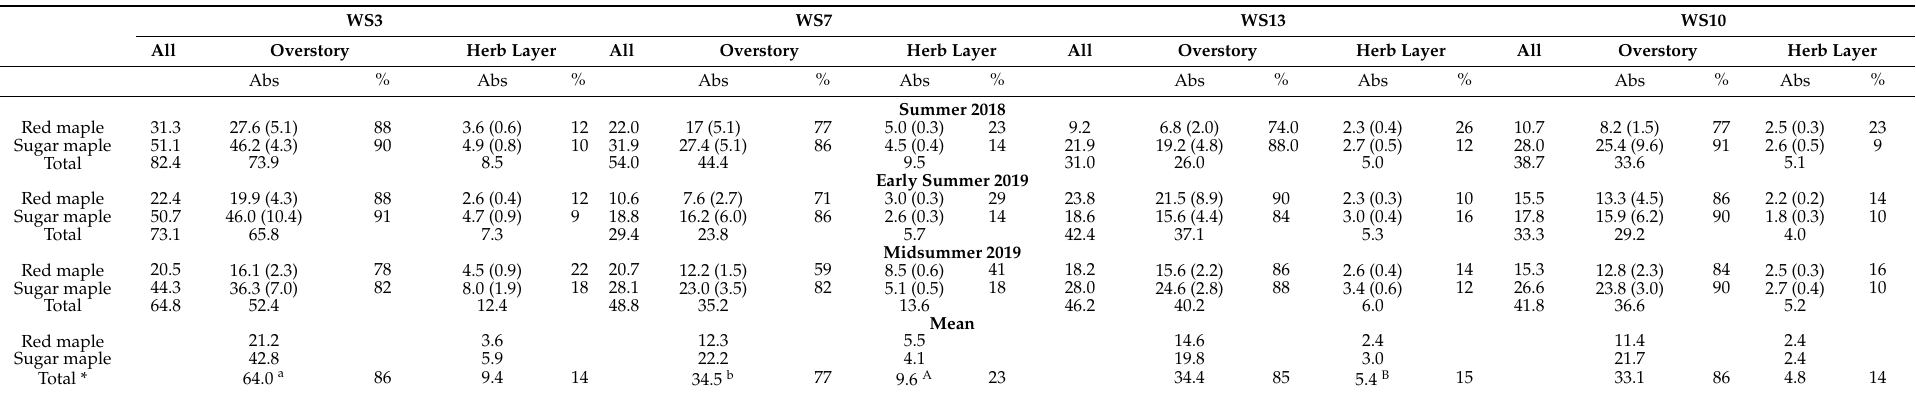
Table 5. Absolute (Abs) and relative (%) values of foliage NRAA for the overstory maples and the herb layer in each watershed (WS) and summer